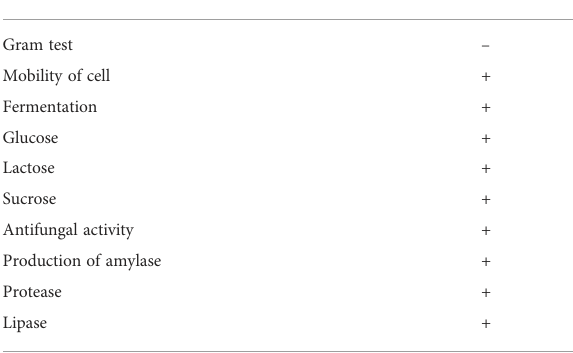
TABLE 1 Morphological and biochemical characterization of selected isolate.